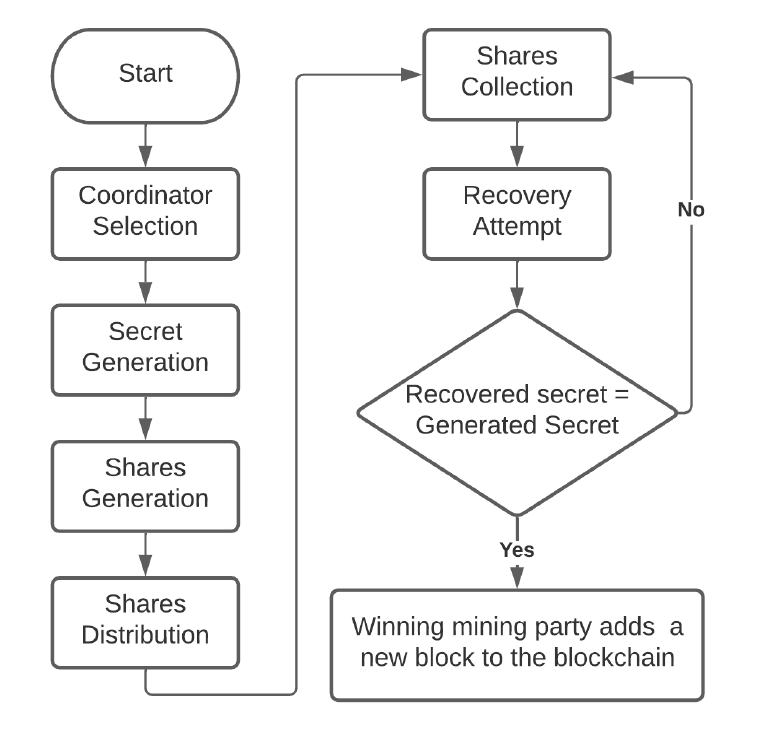
Figure 1. Proof of accuracy